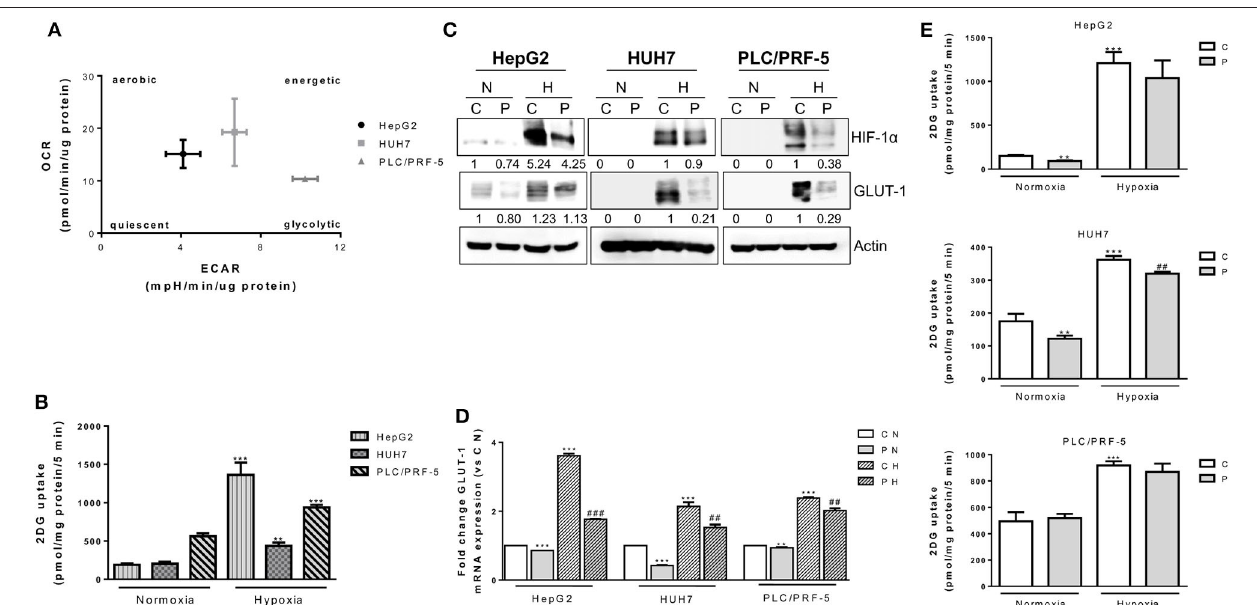
FIGURE 5 | Effects of palbociclib alone on glucose metabolism. (A) HepG2, HUH7, and PLC/PRF-5 cells were analyzed for OCR and ECAR in basal conditions. Data are expressed as pmol/min/ µ g protein and mpH/min/ µ g protein, respectively. (B) HepG2, HUH7, and PLC/PRF-5 cells were exposed to hypoxia for 24h and then analyzed for glucose uptake. Data were calculated and expressed as pmol of 2DG/mg protein/5min. ** p < 0.01, *** p < 0.001 vs. the corresponding value in normoxia. (C) HepG2, HUH7, and PLC/PRF-5 cells were treated with 1 µ M P under normoxic (N) and hypoxic (H) conditions for 24h. The cells were lysed and the expression of the indicated proteins was evaluated by Western blot analysis. (D) The cells were treated as in panel (C) and, after cell lysis, GLUT-1 mRNA expression levels were analyzed by RT-PCR. Results are plotted as 2 − 11 CT ± SD. ** p < 0.01, *** p < 0.001 vs. C N; ## p < 0.01, ### p < 0.001 vs. C H. (E) HepG2, HUH7, and PLC/PRF-5 cells were treated with 1 µ M P under normoxic and hypoxic conditions for 24h and then glucose uptake was measured. Data were calculated and expressed as pmol of 2DG/mg protein/5min. ** p < 0.01, *** p < 0.001 vs. C in normoxia; ## p < 0.01 vs. C in Hypoxia. All data are representative of